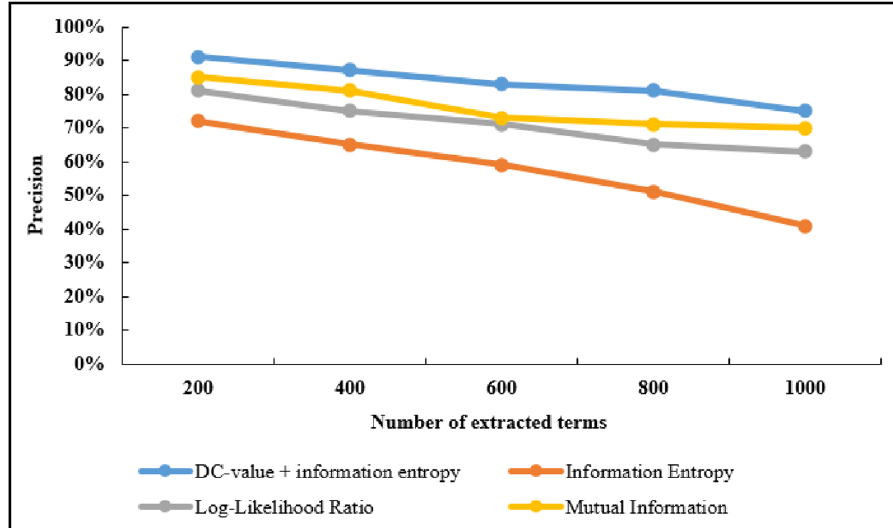
Figure 4. Precision comparison of extraction results.